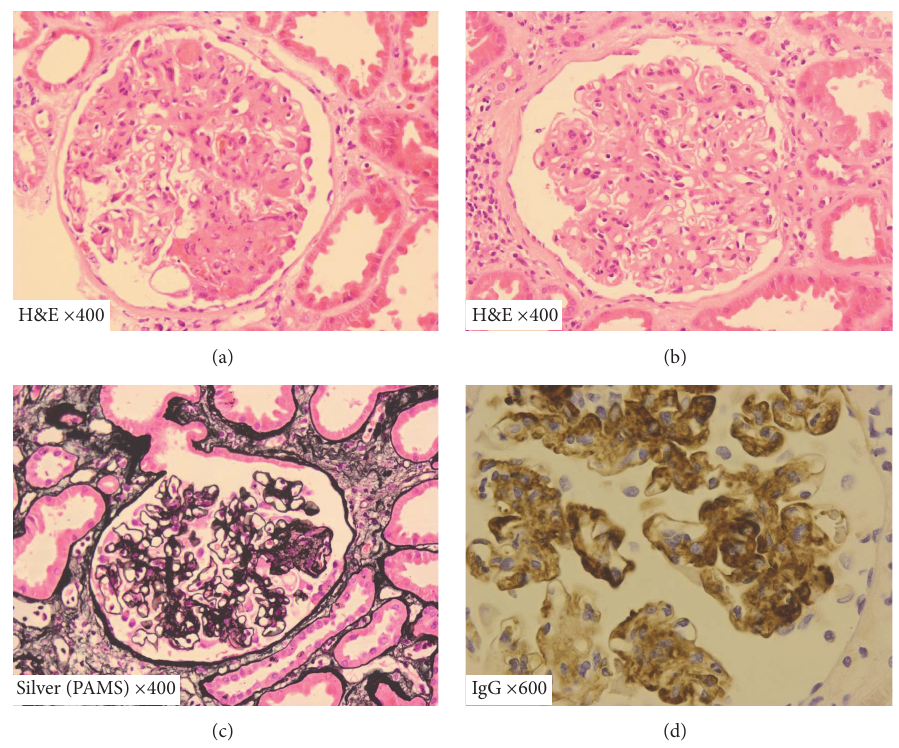
Figure 2: (a) Acute thrombotic occlusion of capillary loops, with segmental endocapillary hypercellularity due to inflammation, with endothelial cell swelling, and with fragmented red blood cells. (b) Mild increase in mesangial cells and moderate expansion of the mesangial matrix. Occasional inflammatory cells in capillary loops. (c) Segmental endocapillary hypercellularity with endothelial cell swelling due to inflammatory cells. (d) Positive staining for immunoglobulin G in the matrix and along glomerular capillary walls. Staining for immunoglobulins A and M and C3 and C1q was also